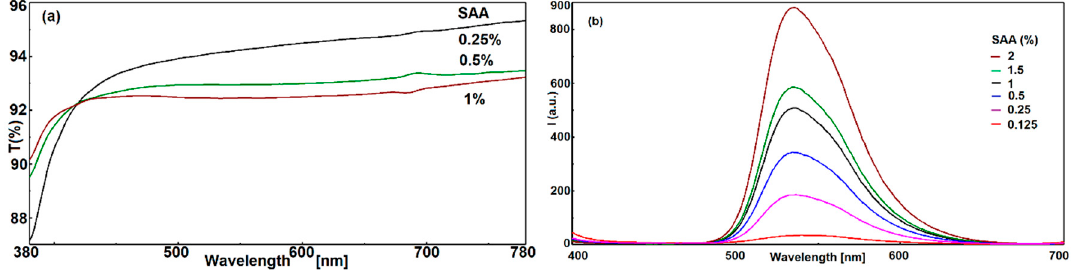
Figure 5. The transmittance ( a ) and fluorescence spectra ( b ) of G5 hybrid films containing different amounts of SAA.